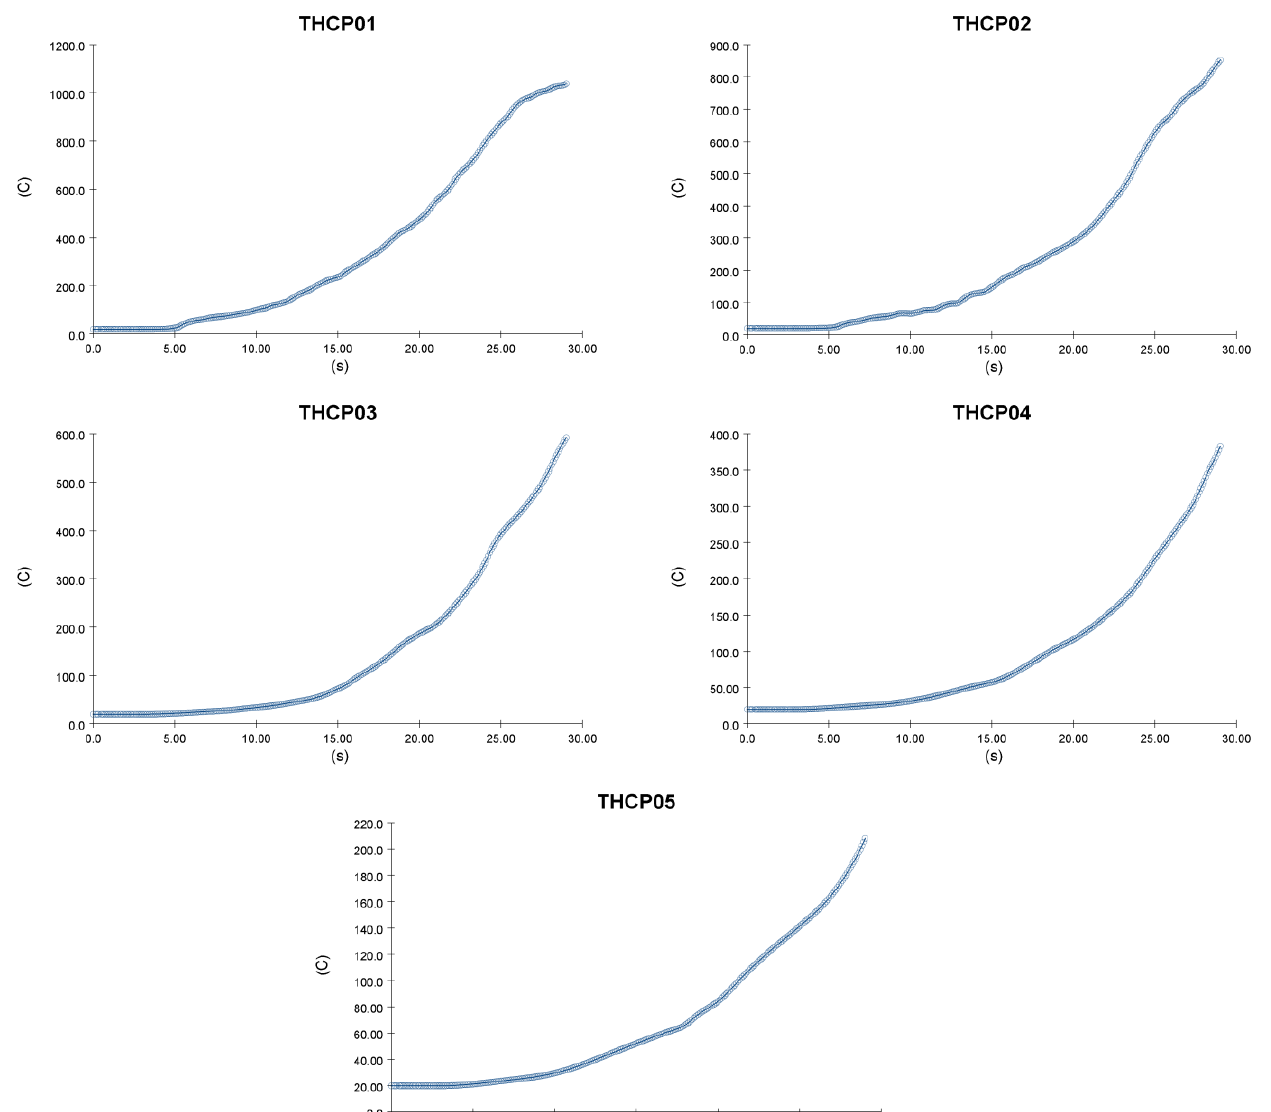
Figure 11. Room temperature evolution in time in the first 30 s of fire simulation (Hypothesis 1).